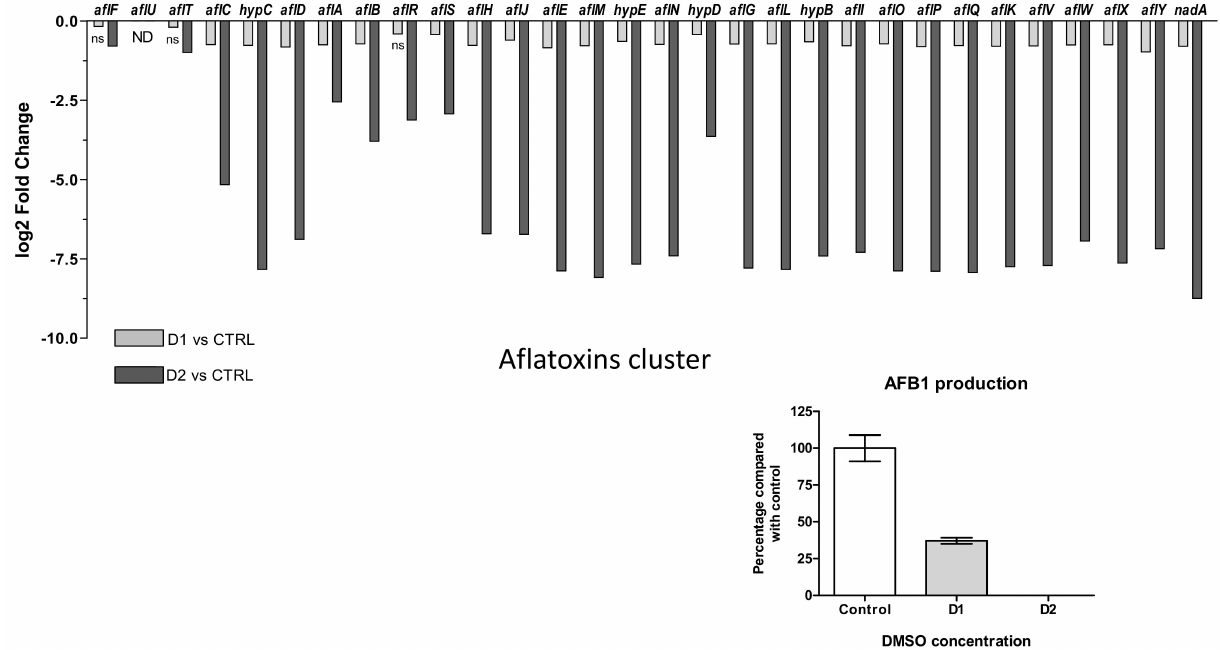
Figure 8. Effect of DMSO treatment on aflatoxin biosynthesis pathway. ( A ) Log 2 Fold Change expression of genes belonging to the aflatoxin biosynthesis cluster (#54) (AFLA_139140-AFLA_139440) in response to DMSO (D1 and D2); only the genes with q -value > 0.05 are indicated as not significantly differentially expressed with “ns” below the bar-plot; “ND” means not detected. ( B ) Impact of DMSO on AFB1 production of Aspergillus flavus NRRL 62477 after 4 days at 27 ◦ C. Results are expressed as percentage of the control value (+/ −